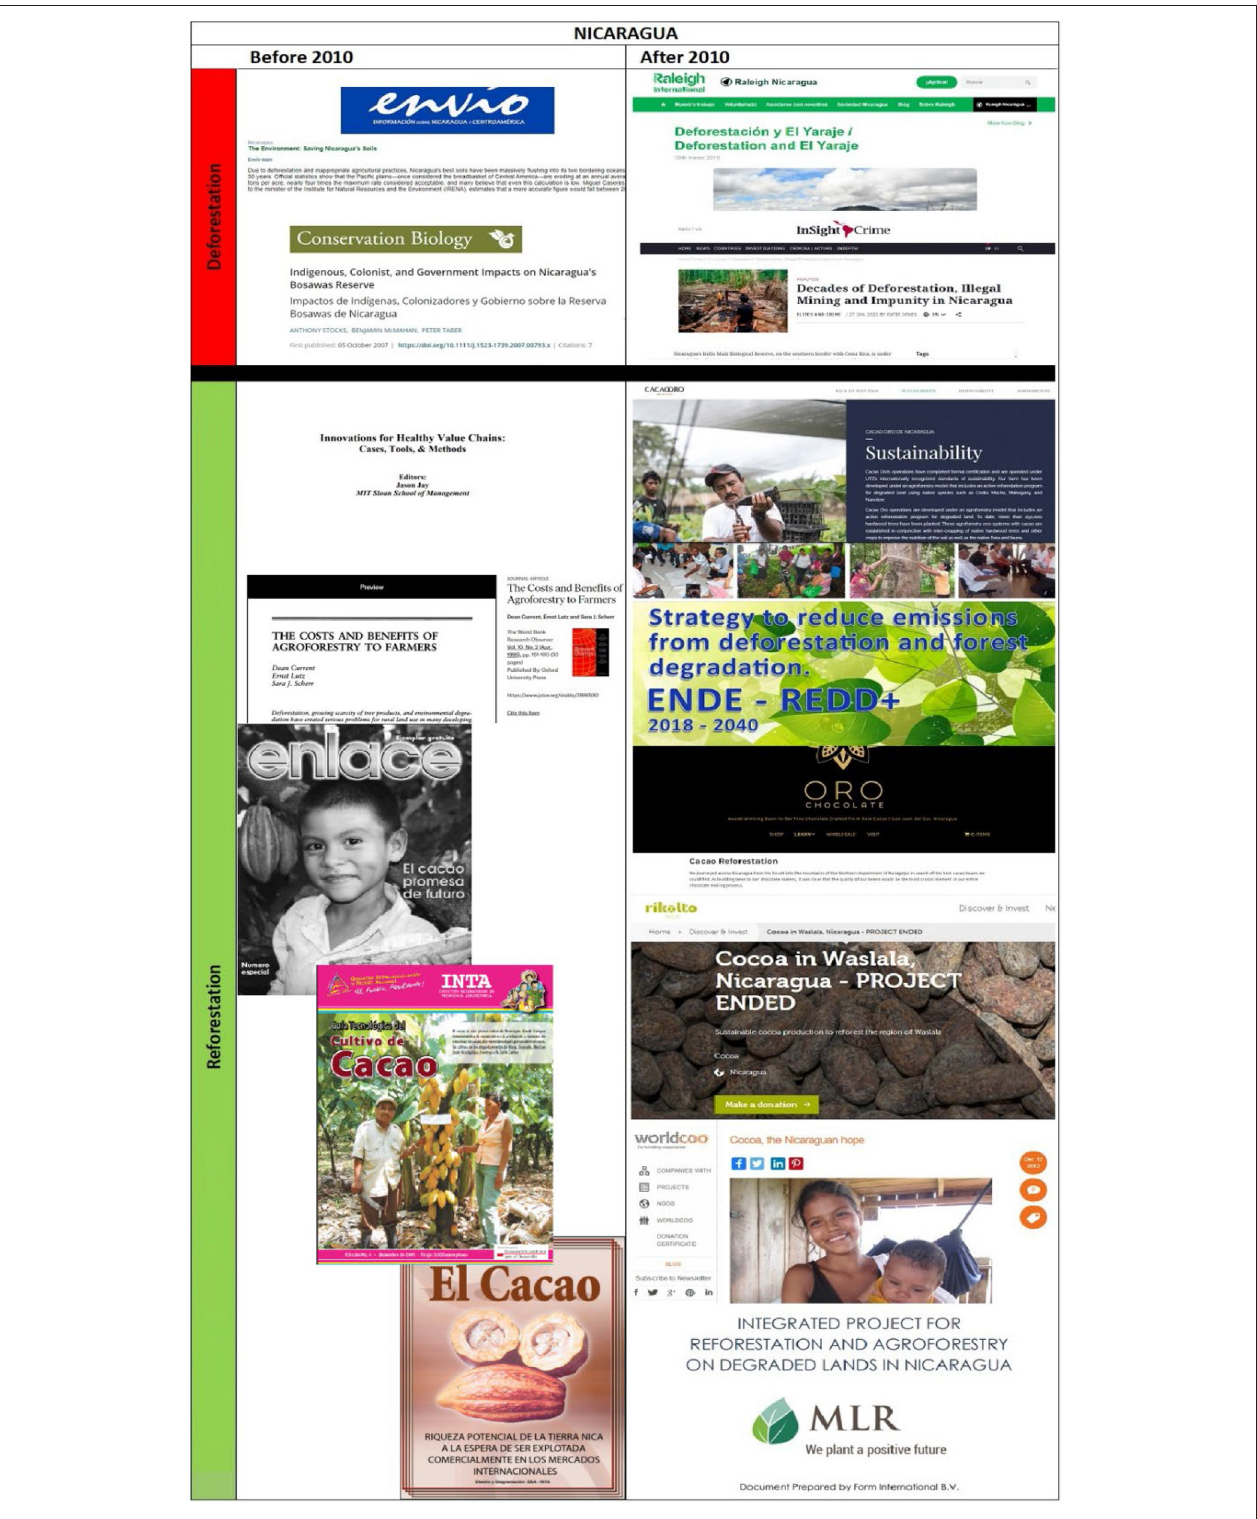
FIGURE 2 | Nicaragua’s media outlook (before and after 2010) linking cocoa cultivation to reforestation and deforestation.